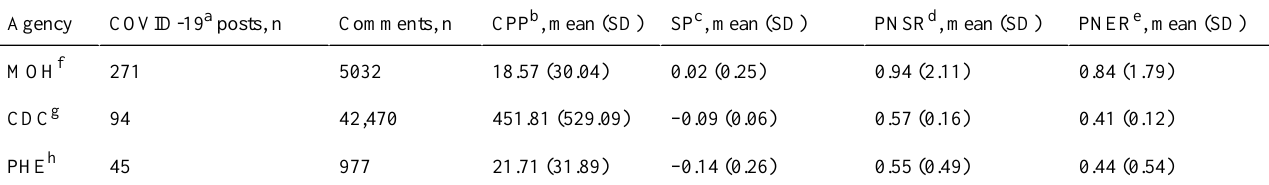
Table 4. Emotion and sentiment analyses of COVID-19 Facebook comments.